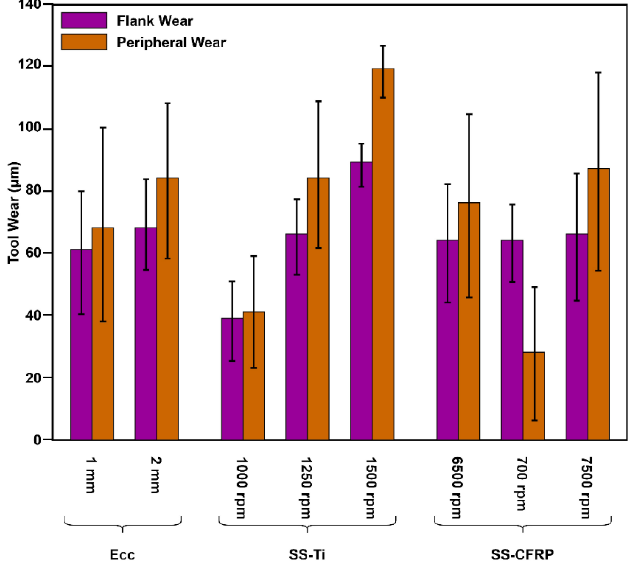
Figure 13. Trend plot (eccentricity, spindle speeds) of tool wear during hole-making in CFRP/Ti6Al4V.